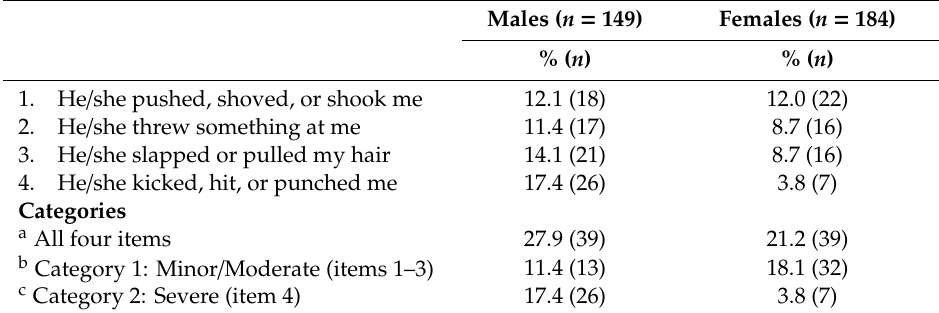
Table 3. Prevalence of physical TDV victimization by item and three